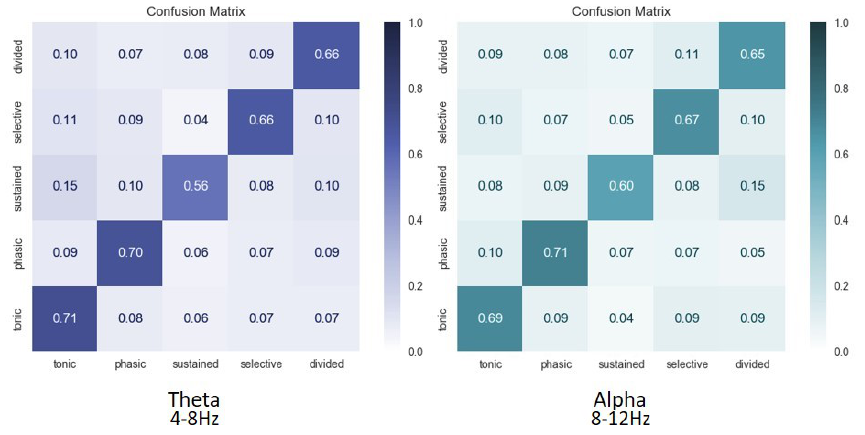
Figure 7. Average confusion matrices over all subjects for classification of attention in theta (4–8 Hz) and alpha (8–12 Hz) frequency bands of 5 attentional states, i.e., alertness (tonic), alertness (phasic), sustained, selective, and